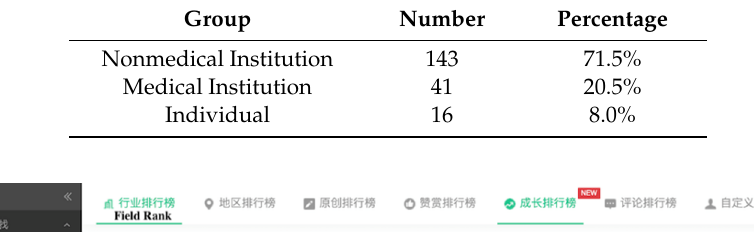
Figure 1. Data collection process. Table 2. Groups and numbers of o ffi cial accounts.